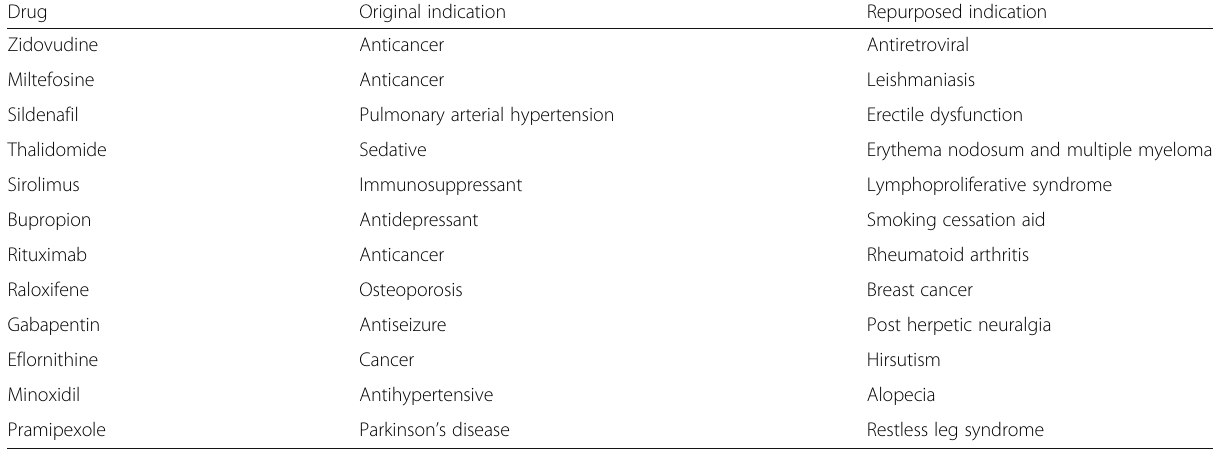
Table 2 Examples of successfully repurposed drugs